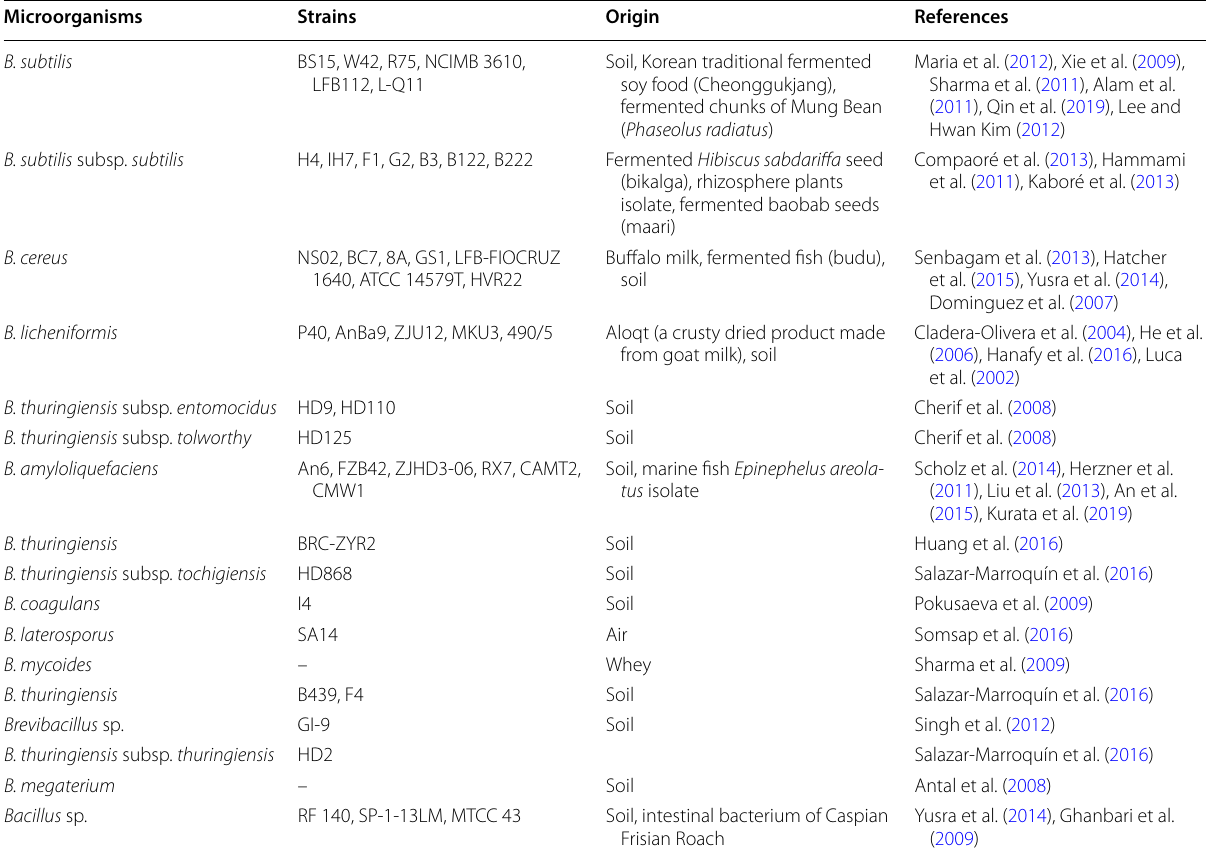
Table 6 Bacteriocin-producing strains from Bacillaceae